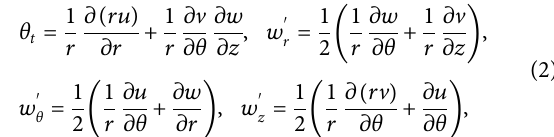
Frontiers in Materials |